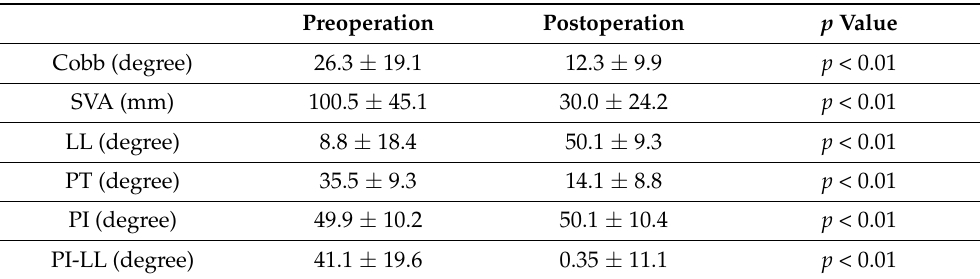
Table 3. Preoperative and postoperative spine and pelvic parameters.